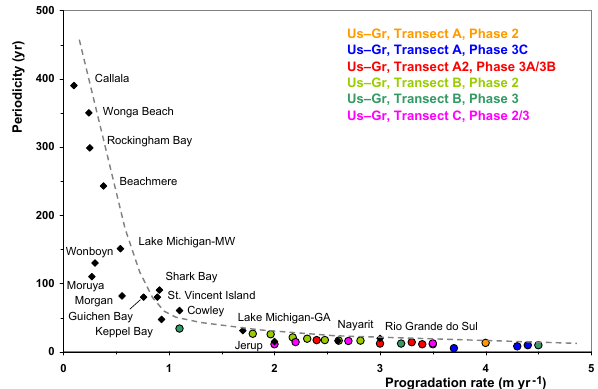
Figure 12. Periodicities of beach-ridge formation for the Usumacinta–Grijalva (Us–Gr) system compared with reported or estimated values for other large beach-ridge systems: Rocking- ham Bay (Forsyth et al., 2010), Beachmere (Brooke et al., 2008b), Moruya (Oliver et al., 2015), Guichen Bay (Murray Wallace et al., 2002; Bristow and Pucillo, 2006), Keppel Bay (Brooke et al., 2008a), Shark Bay (Nott, 2011), Cowley Beach (Nott et al., 2009), Lake Michigan (Thompson, 1992), St. Vincent Island (Lopez and Rink, 2008; Rink and Lopez, 2010), Jerup (Nielsen et al., 2006), Nayarit (Curray et al., 1969), and Rio Grande do Sul (Milana et al.,